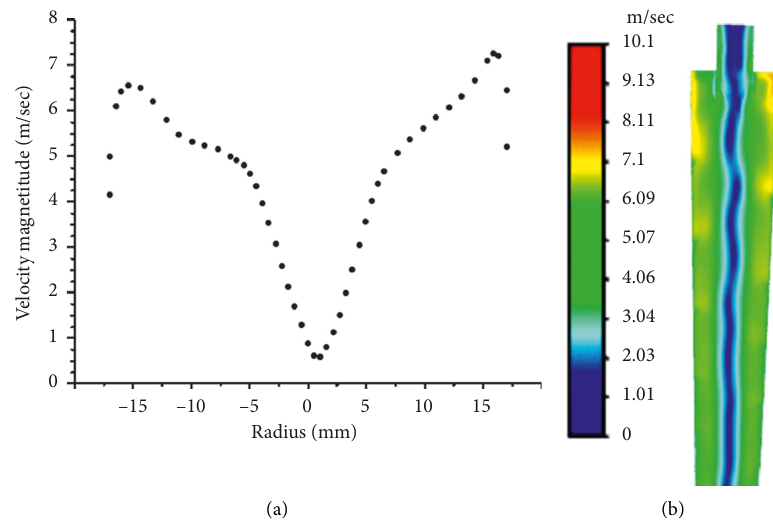
Figure 8: (a) Diagram and (b) contour of velocity magnitude within the hydrocyclone.